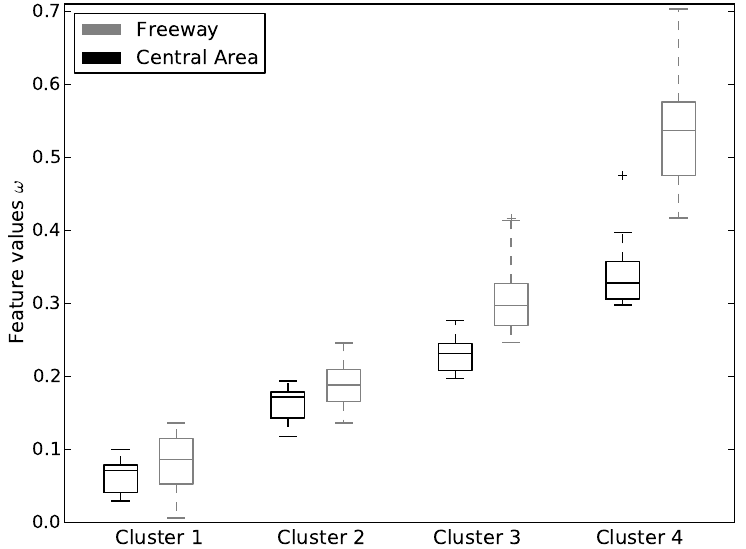
Figure 4. A whisker plot showing the distribution of the feature values among the different clusters for our two experimental setups. The box marks the boundaries of the first and third quartiles, while the bars indicate the full extent of the feature values in that cluster. The horizontal line indicates the median. As we can see, the first cluster and—on the other hand—the second and third cluster are well separated in terms of feature values. There is a continuous overlap from the second to the third cluster. These two clusters represent the majority of the drivers with an average-fuel-consuming driving style, with a tendency towards being more (cluster 2) or less (cluster 3) energy efficient. The first cluster represents the energy-saving drivers and the last cluster represents the drivers with high fuel consumption, also containing noisy driver patterns. Thereby, the lower the feature values are, the more energy saving the corresponding driving style